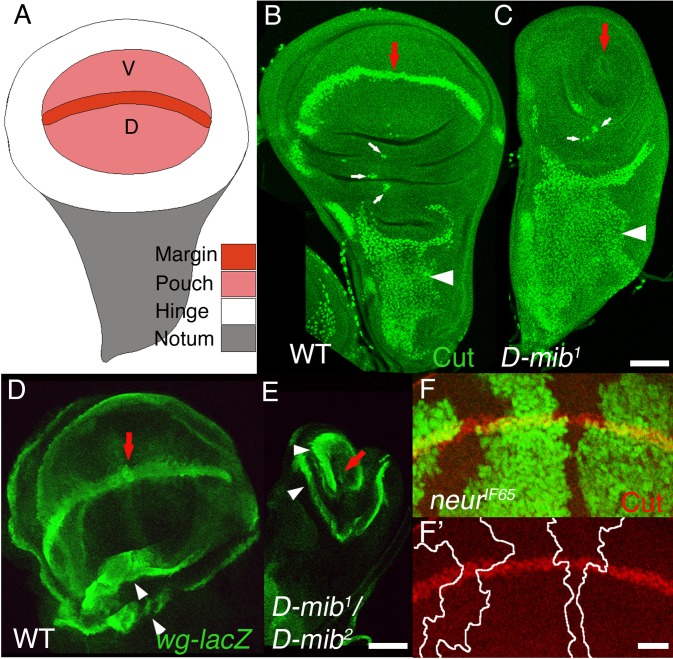
The D-mib and neur Genes Have Distinct Functions during Wing Development(A–E) Wing imaginal discs (B–E) from wild-type (B and D), D-mib1 (C), and D-mib1/D-mib2 (E) third instar larvae stained for Cut (B and C) and wg-lacZ (D and E). D-mib mutant discs showed a dramatically reduced size of the wing pouch (see diagram in [A] showing the different regions of the wing imaginal disc; V, ventral; D, dorsal), as well as a complete loss of Cut and wg-lacZ (red arrows in [B–E]) expression at the wing margin. Expression of wg-lacZ in the hinge region (arrowheads in [D] and [E]) and the accumulation of Cut in sensory cells (small arrows in [B] and [C]) and muscle precursor cells (large arrowheads in [B] and [C]) appeared to be largely unaffected).(F and F′) Expression of Cut (red) at the wing margin was not affected by the complete loss of neur activity in neur1F65 mutant clones (indicated by the loss of the nuclear green fluorescent protein [GFP] marker, in green).Bar is 50 μm in (B–E) and 20 μm in (F and F′).